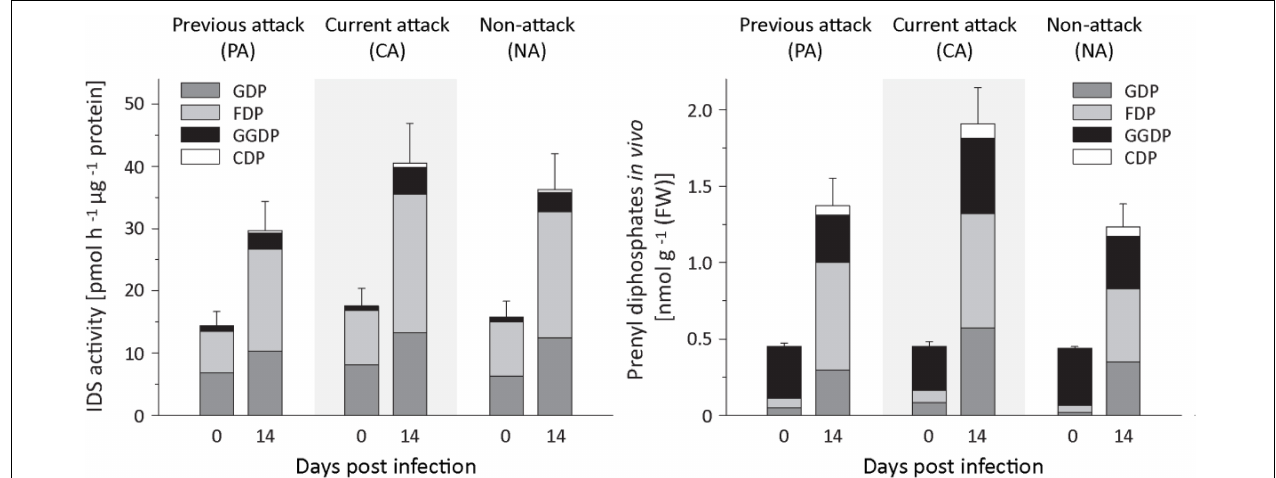
FIGURE 6 | Quantification of IDS enzyme activity and prenyl diphosphate levels in spruce bark before and after Endoconidiophora polonica infection. The IDS enzyme activity of total protein extracts was assayed in vitro with IDP and DMADP as substrates (left panel). The abundance of the prenyl diphosphates GDP, FDP, GGDP, and CDP in spruce bark tissue in vivo was measured by LC-MS/MS. Trees investigated: (1) were from a stand with a history of previous bark beetle attack, but no current attack (PA), (2) were under current attack, but had no previous history of attack (CA), or (3) had no previous nor current attack (NA). Data are means ± SD of measurements from 6 to 12 biological replicates; exact numbers are given in the Section “Materials and Methods.” Statistical values for individual compounds are given in Supplementary Tables 7, 8 .